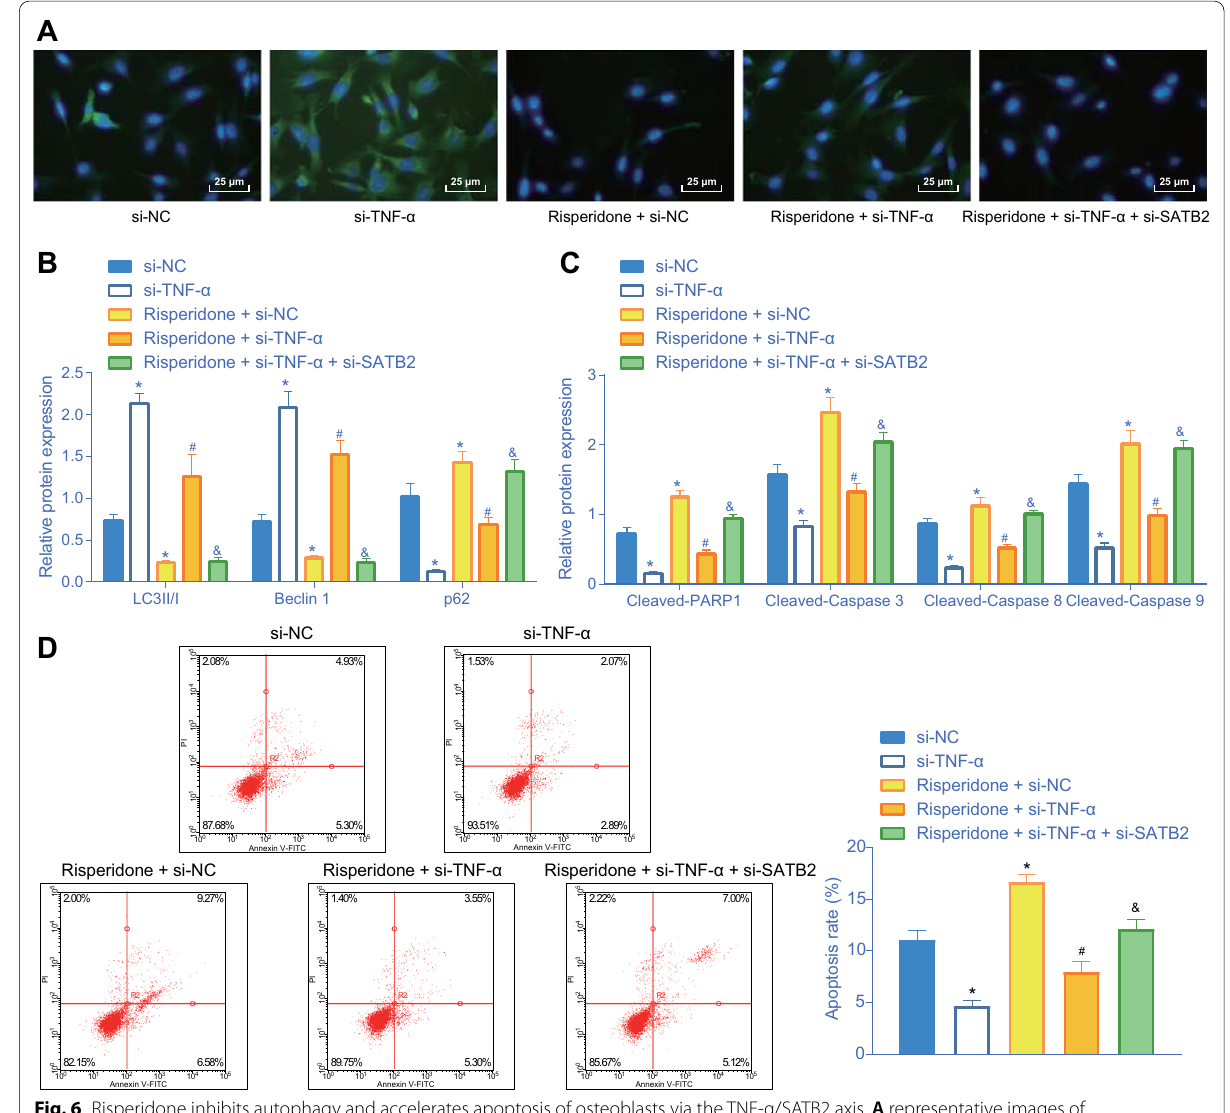
Fig. 6 Risperidone inhibits autophagy and accelerates apoptosis of osteoblasts via the TNF-α/SATB2 axis. A representative images of autophagosome in MC3T3-E1 cells assessed by immunofluorescence. B Western blot analysis of autophagy-related protein (LC3 II/I, Beclin1, and p62) expression in MC3T3-E1 cells. The band intensity was quantified. C Western blot analysis of apoptosis-related proteins (cleaved PARP1, cleaved caspase-3, cleaved caspase-8 and cleaved caspase-9). The protein band was quantified. D apoptosis rate of MC3T3-E1 cells determined by flow cytometry. * p < 0.05, compared with MC3T3-E1 cells treated with si-NC. # p < 0.05, compared with MC3T3-E1 cells treated with Risperidone & p < 0.05, compared with MC3T3-E1 cells treated with